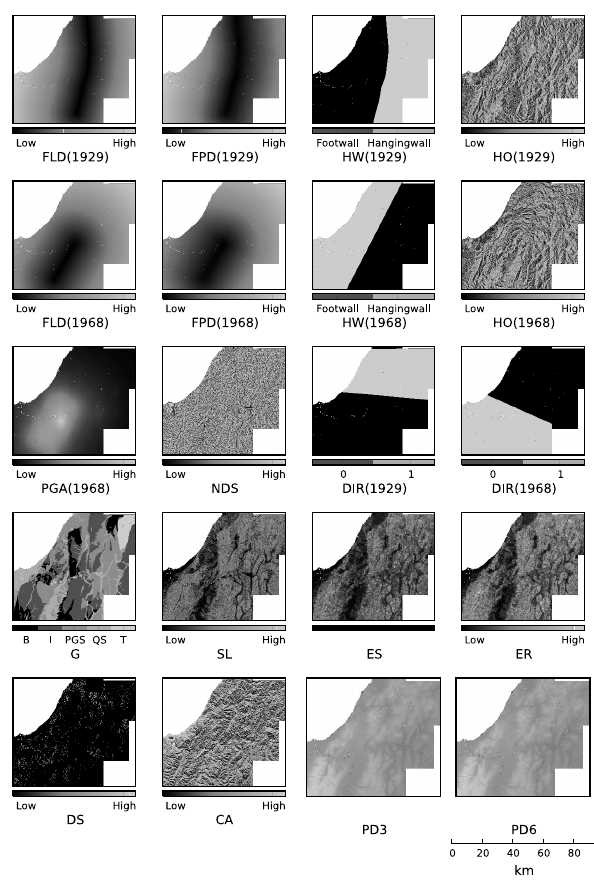
Figure 10. Matrix of maps showing potential predictor variables used in logistic regression analysis of hillslope failure probability. Each map shows distributed values of each predictor variable across the 5629km 2 combined area of landslide mapping for both events (as shown in Fig. 1). Variable descriptors and units are summarised in Table